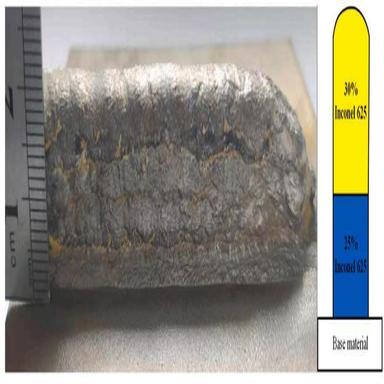
A single-bead multilayer wall using AC inter-wire arc additive manufacturing.